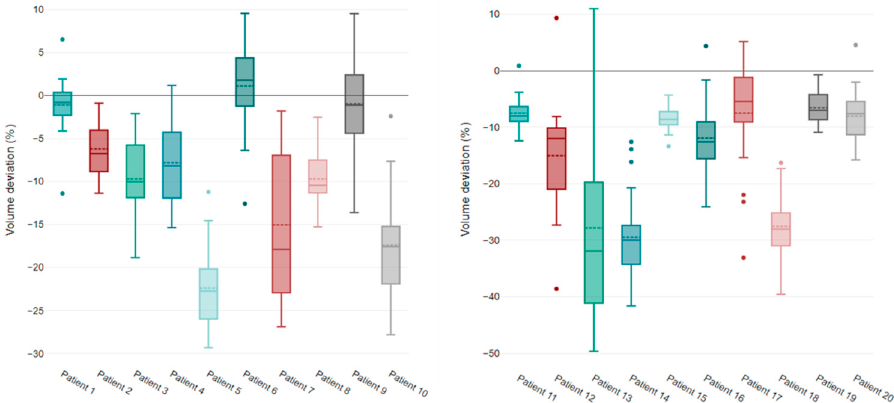
Figure 3. Box plot showing the variation in breast ( left ) and chest wall ( right ) CTV values in each patient ( n = 20) during treatment.